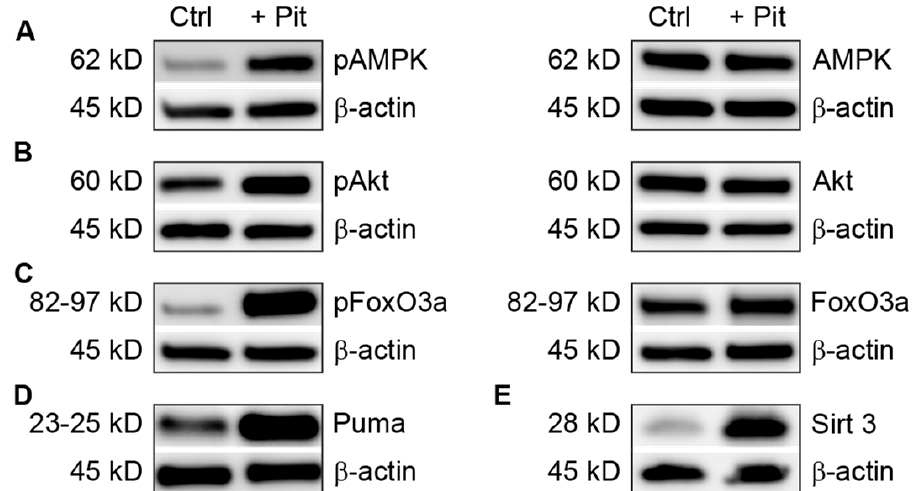
Figure 5. Pitavastatin effects on metabolic regulators. REH-VR cells were treated with 450 nM pitavastatin (+ Pit) or DMSO vehicle control (Ctrl). ( A – C ) Western blot analysis shows phosphorylated and total protein levels following 48 h treatment. ( D ) Puma and ( E ) Sirt3 expression were also increased with Pit treatment. Phospho-FoxO3a blot shown is for phospho-FoxO3a (Ser413).